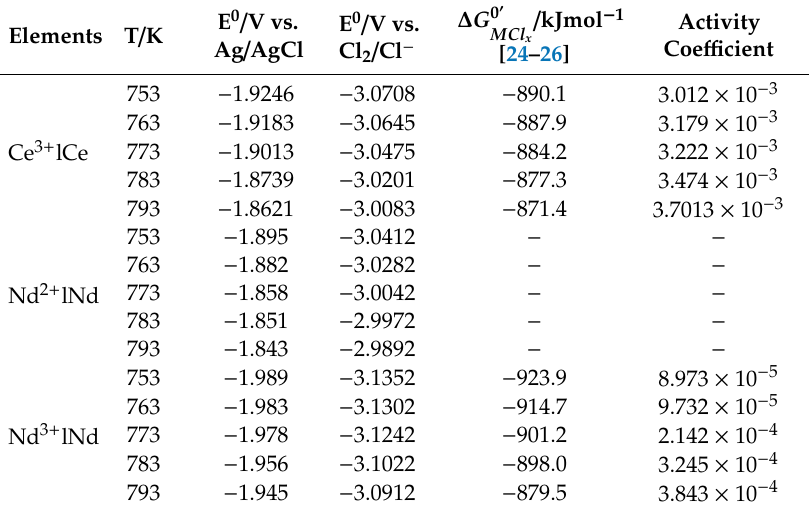
Table 1. Standard-state Gibb’s free energy of the theoretical supercooled value for NdCl 3 and CeCl 3 and activity coe ffi cient as a function of temperature